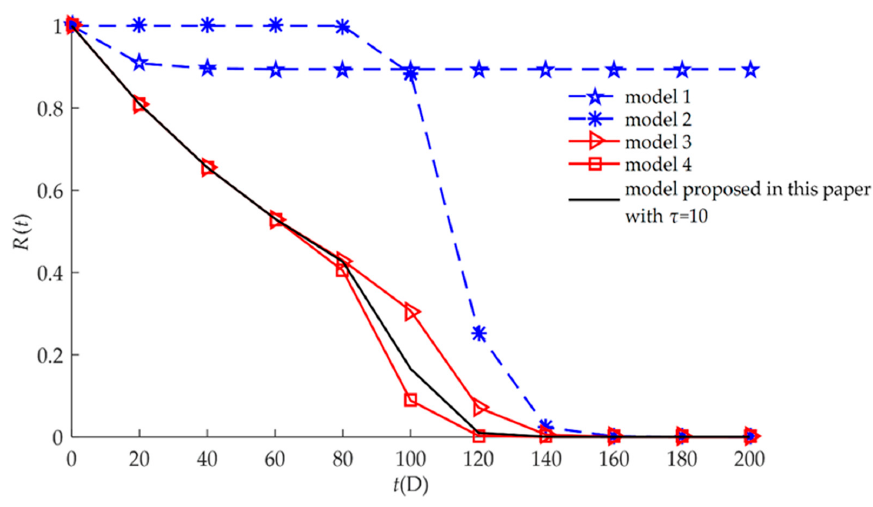
Figure 8. Comparison of R ( t ) for different models for example II.